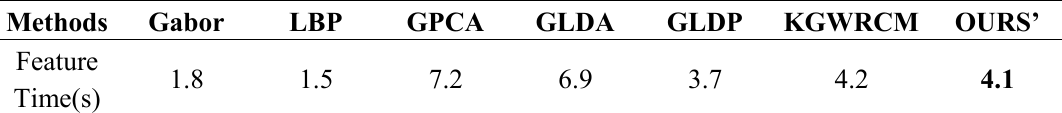
Table 3. The time consumed of each method per 300